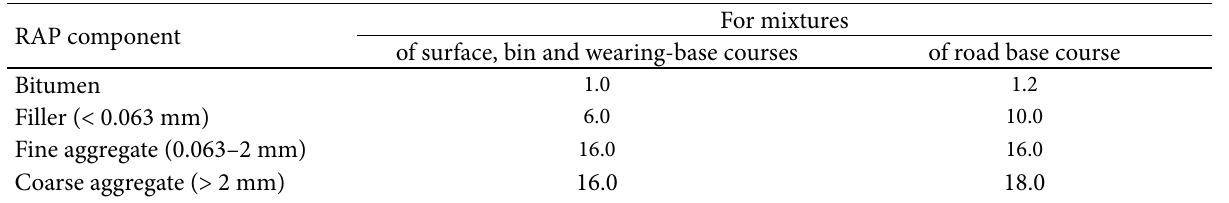
Table 3. General permissible deviations N adm,i for the gradation of particle of RAP granules (constant coefficients) For mixtures RAP component of surface, bin and wearing-base